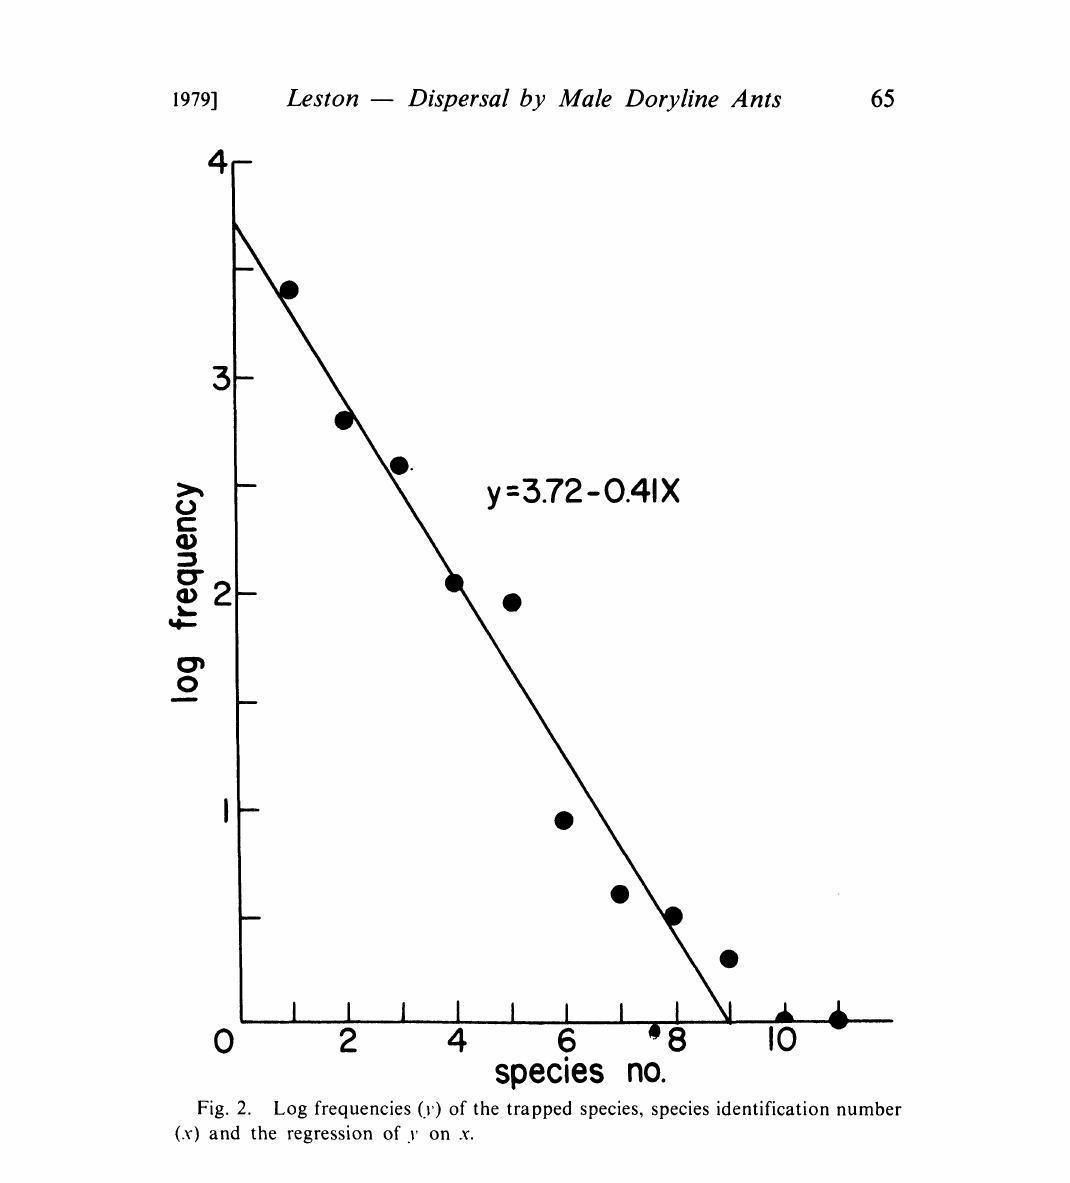
Fig. 2. Log frequencies (y) of the trapped species, species identification number (x) and the regression of on